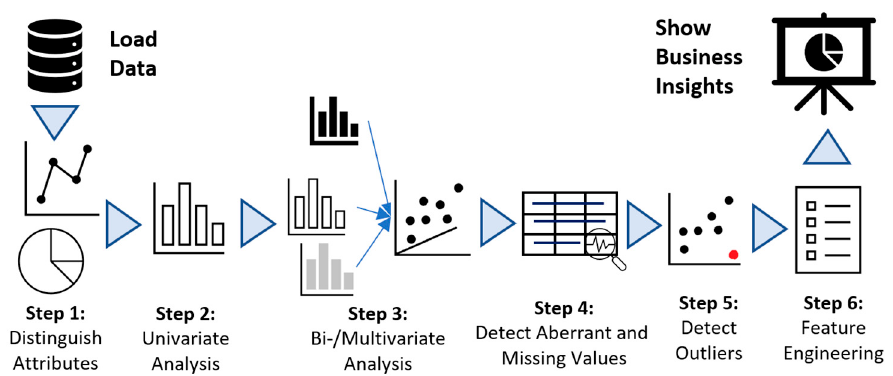
Figure 2. Exploratory data analysis (EDA) steps.